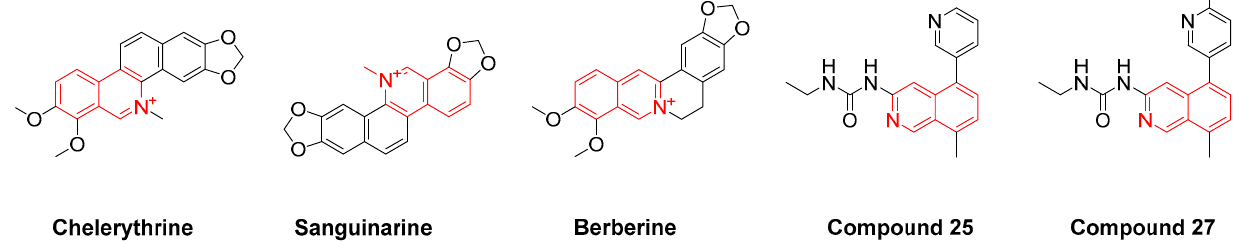
Figure 1. Structures of antimicrobial compounds with an isoquinoline moiety.